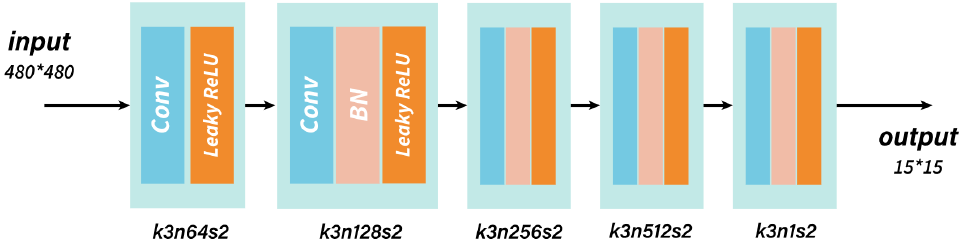
Figure 5. Details of the PatchGAN discriminator. k means the kernel size, n represents the number of channels and s denotes the stride.